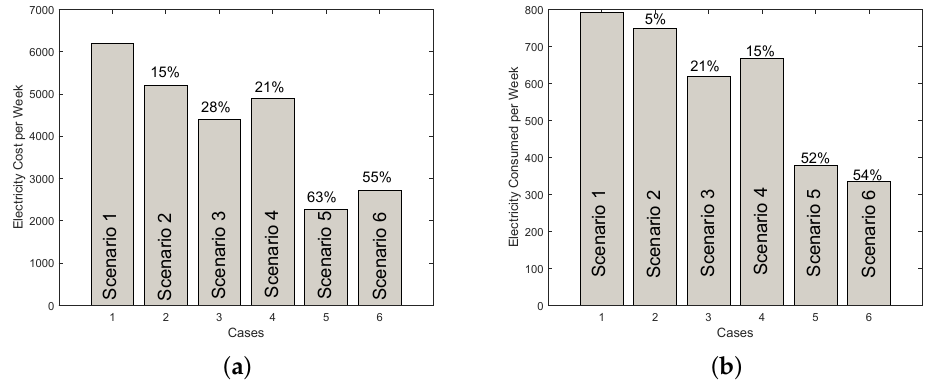
Figure 11. Cost and energy analysis. ( a ) Cost saving analysis; ( b ) energy consumption analysis.